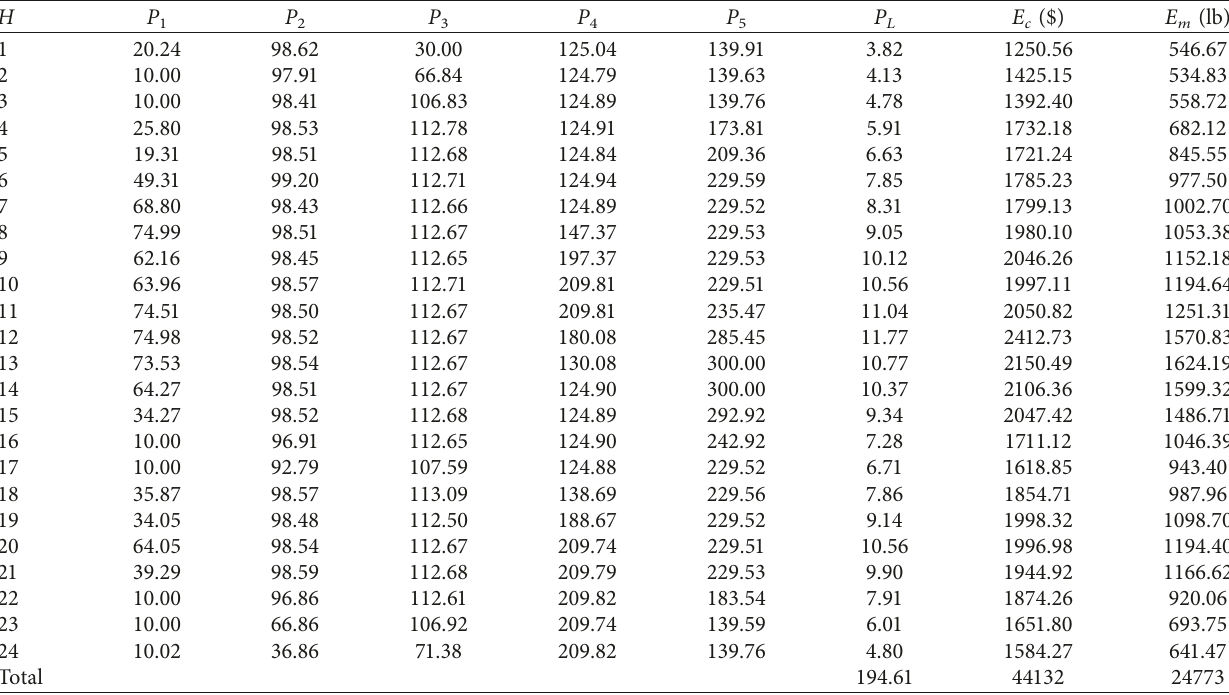
Table 2: Optimal results for Case 1 (optimal